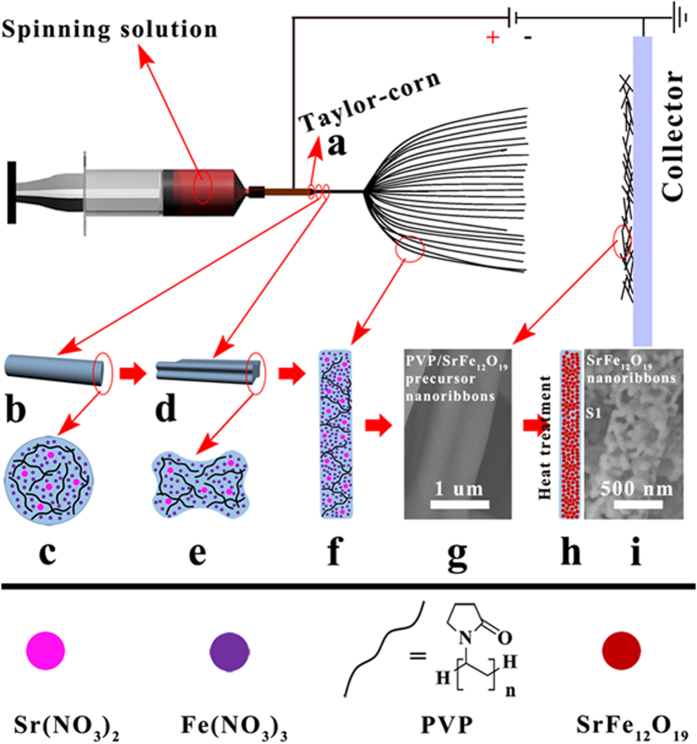
Schematic diagram of the formation mechanism of SrFe12O19 nanoribbons.